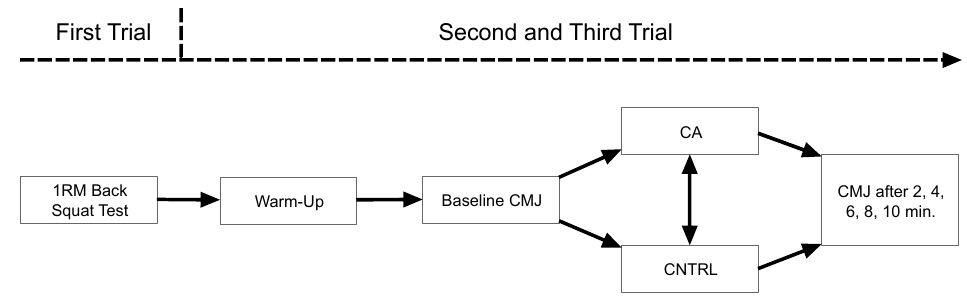
Figure 1. Study design. 1RM—one repetition maximum; CMJ—countermovement jump; CA—con- Figure 1. Study dition used velocity controlled conditioning activity; CNTRL—control condition.